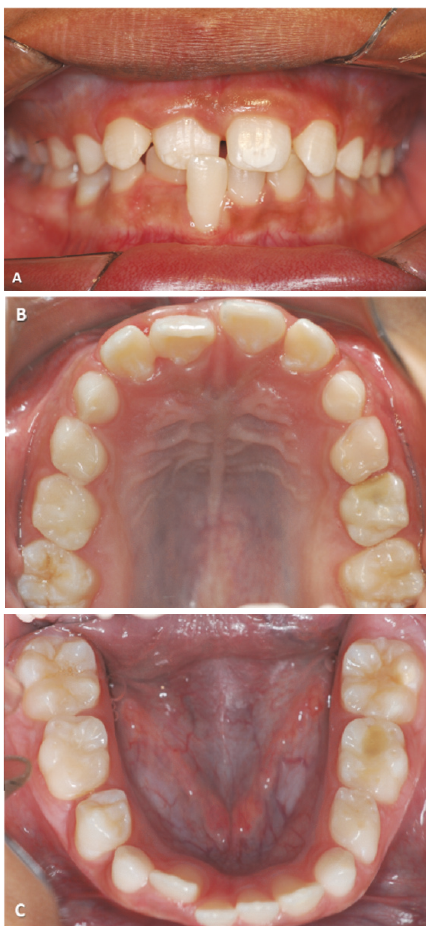
Figure 3: Facial view of permanent teeth, note the erupted position change of the tooth (11) in the dental arch and the tooth (11) with enamel